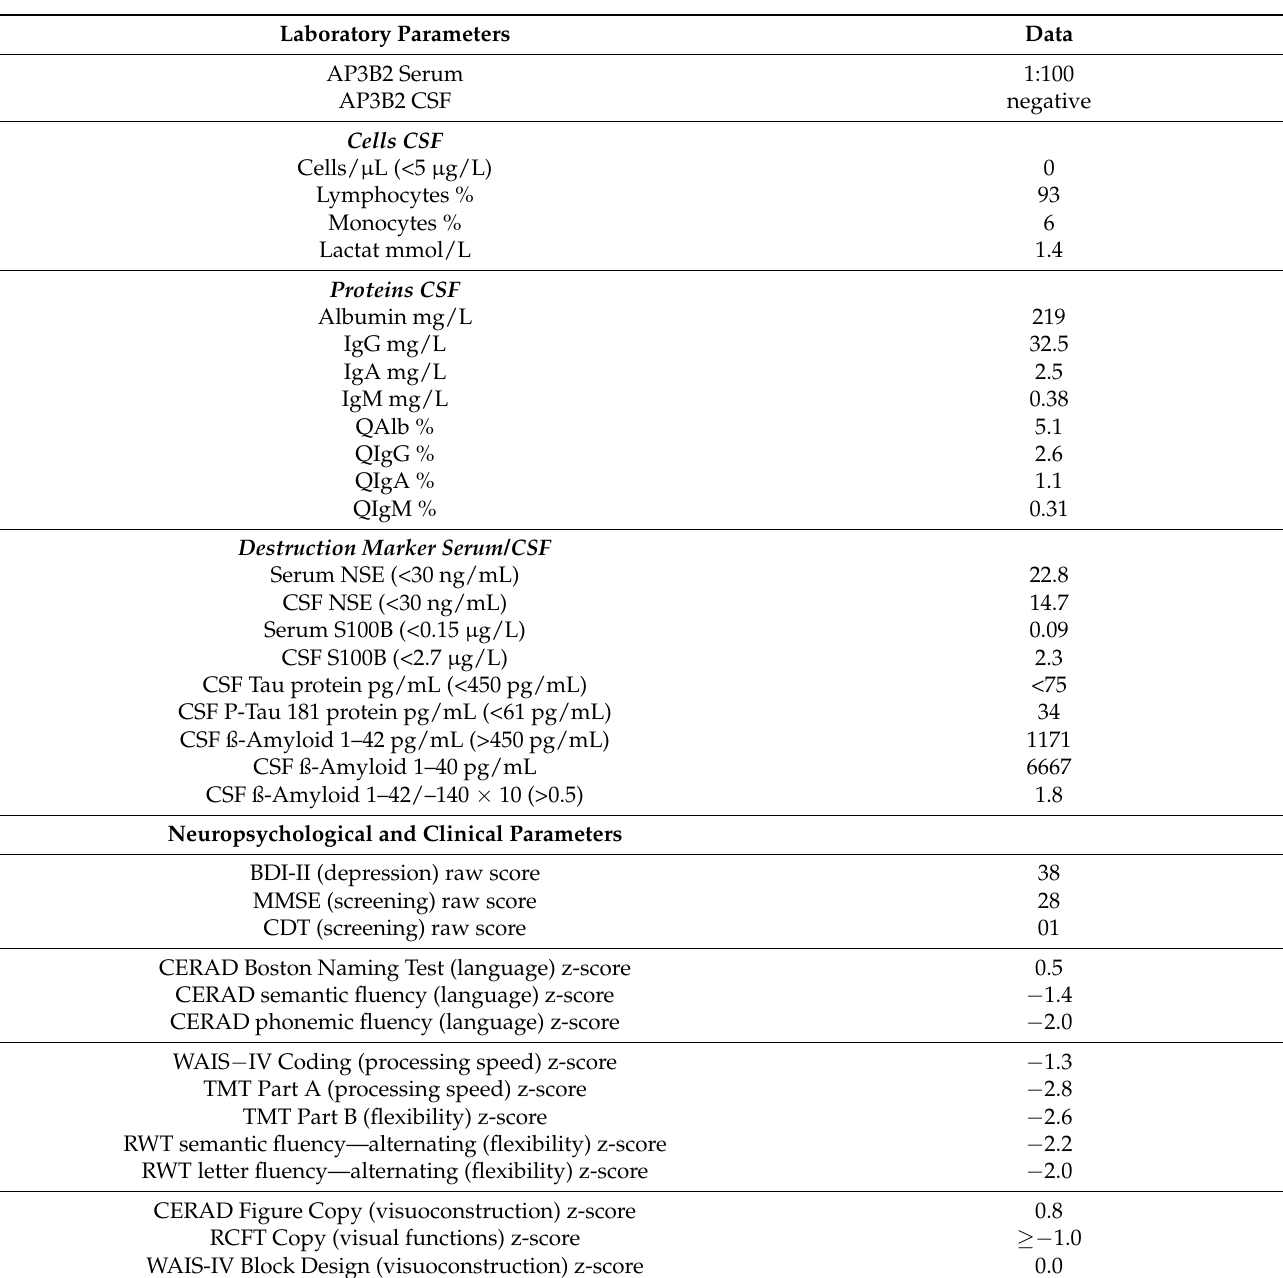
Table 2. Laboratory and clinical data at first presentation.